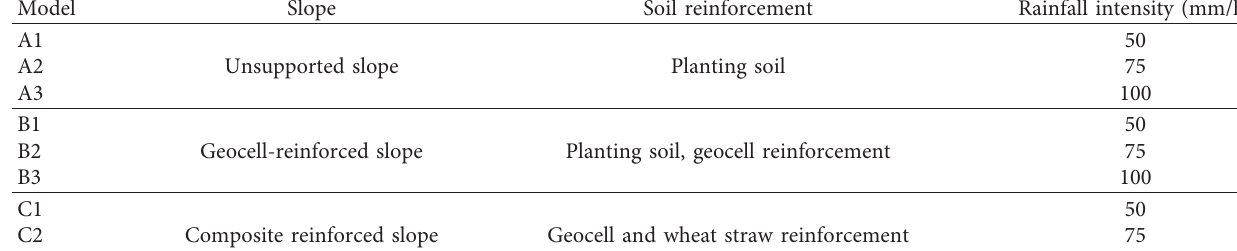
Table 1: Soil reinforcement and rainfall intensity for different models.